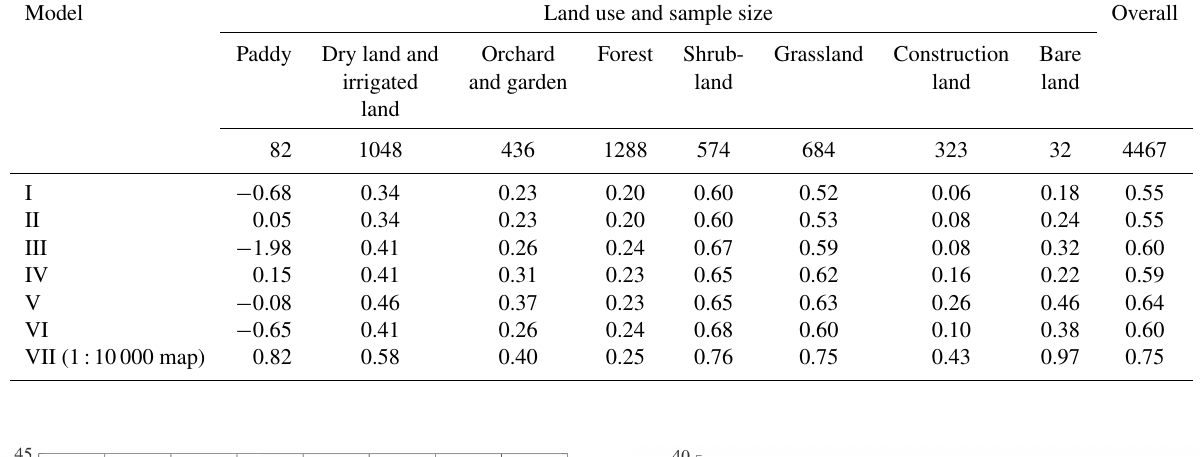
Table 2. Model efficiency coefficient (ME) for seven models using bivariate penalized spline over triangulation (BPST) per land use. Model